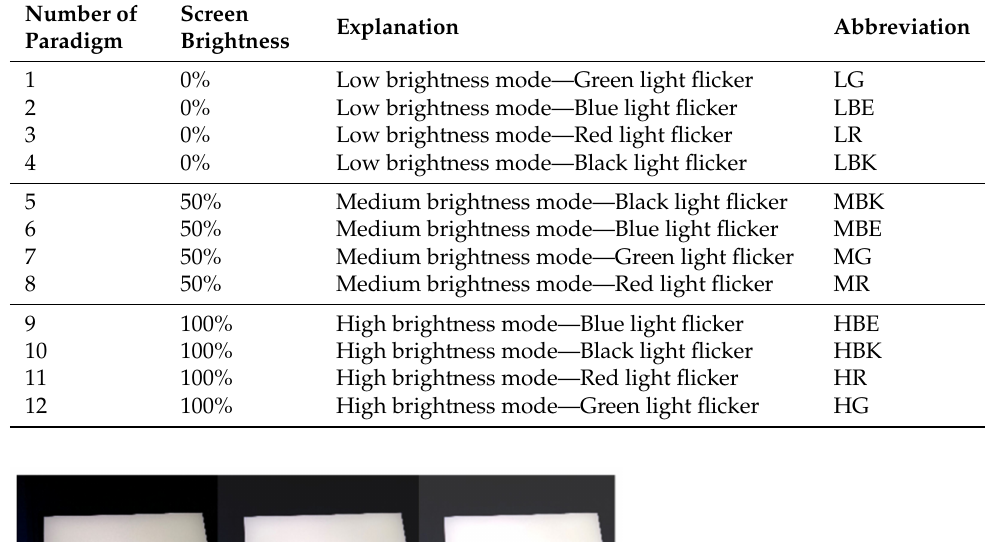
Table 1. Design of Paradigms.